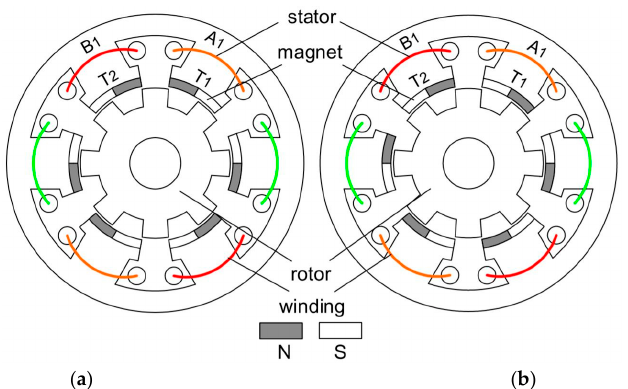
Figure 7. Configurations of flux-reversal PM (FRPM) machines with two magnetization methods: ( a ) Magnets on the adjacent stator teeth that are reversely magnetized (NS-SN); ( b ) Magnets on all the stator teeth are magnetized in the same way (NS-NS) [21].